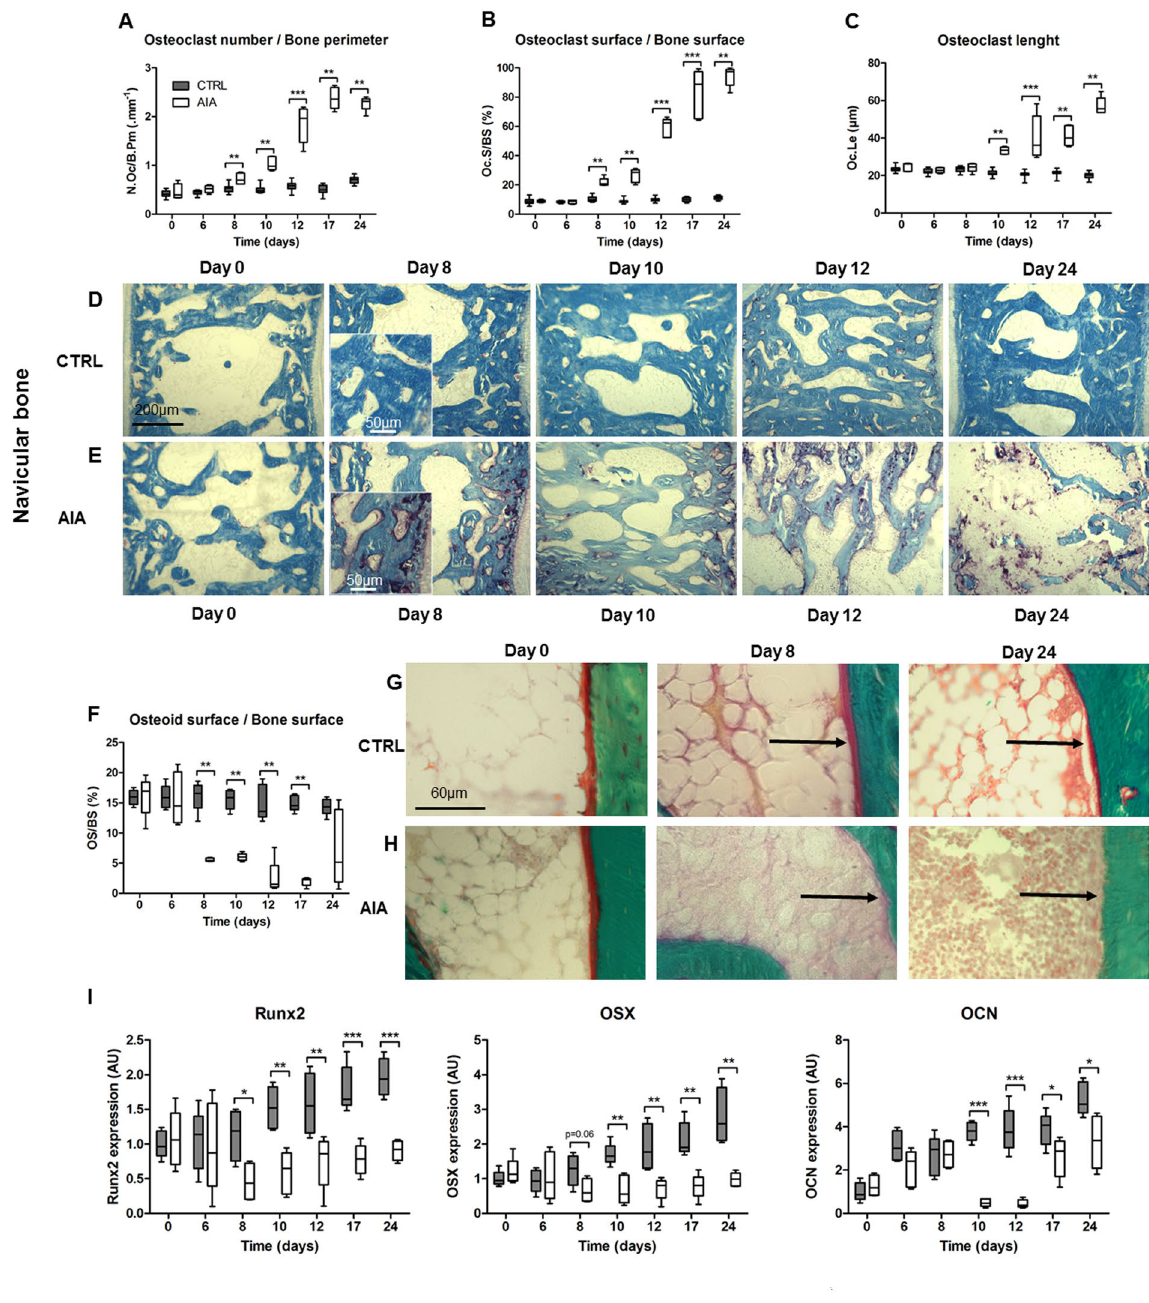
Figure 3. Early bone uncoupling was assessed: increased bone resorption and decreased mineralization were observed. Histological assessment of osteoclast with TRAcP5 + cell staining: ( A ) N.Oc/B.Pm, ( B ) Oc.S/BS, and ( C ) Oc.Le. Representative slices were provided from rats at days 0, 8, 10, 12 and 24 in CTRL ( D ) and AIA ( E ). Bone tissue and TRAcP5 + cells were stained in blue and purple, respectively. Scale bar: 200 µ m, except for the inset (scale bar: 25 µ m). ( F ) Osteoid matrix deposit on modified Goldner trichrome quantified with OS/BS, with representative slices from CTRL group ( G ) and AIA group ( H ). Osteoid layer along mineralized trabeculae and marrow cavity were stained in red, green, and yellow, respectively. Scale bar: 60 µ m. (I) Osteoblastic markers decreased in the AIA group included RUNX2, OSX, and OCN. N.Oc/B.Pm: number of osteoclasts by bone perimeter; Oc.S/BS: osteoclast surface by bone surface; Oc.Le: osteoclast length; OS/BS: osteoid surface by bone surface; RUNX2: Runt-related transcription factor 2; OSX: osterix; OCN: osteocalcin. Boxes and bars were median ± interquartile range. Mann-Whitney test: ** p < 0.01 and *** p <